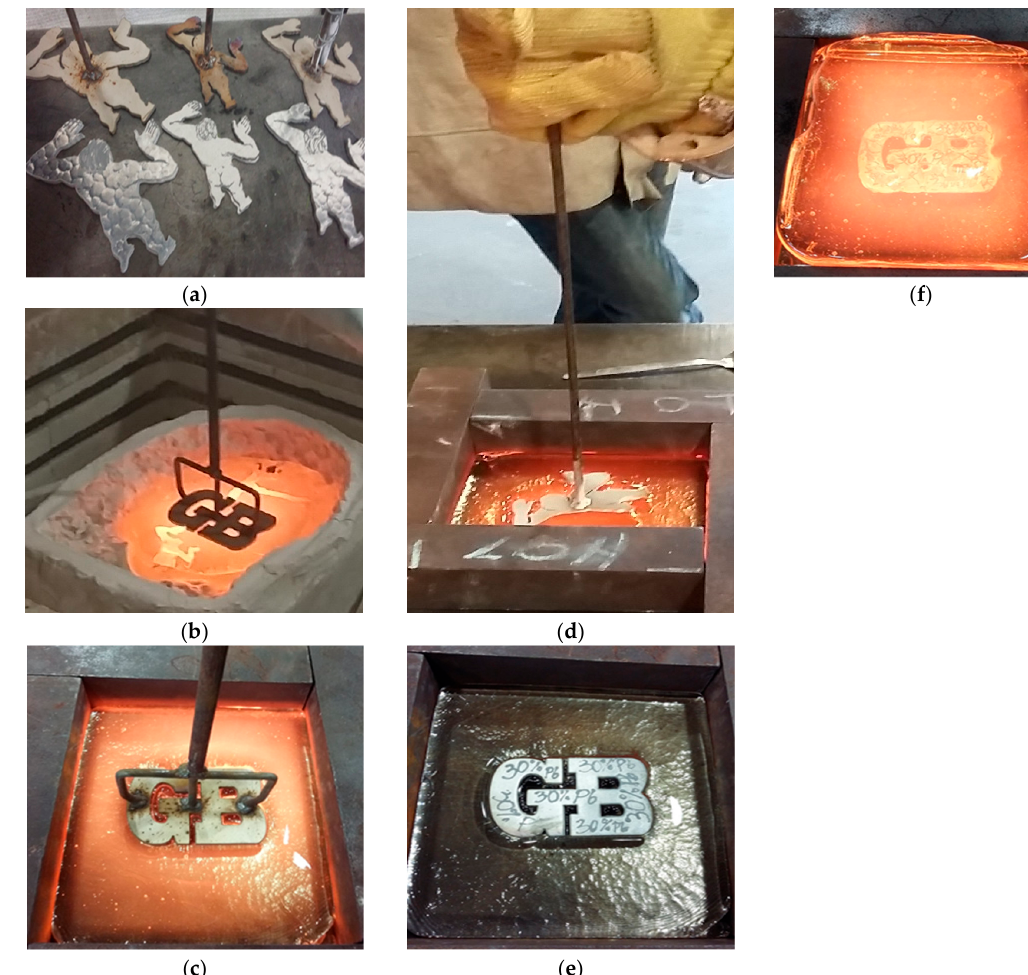
Figure 13. Stamps to make indentations in hot glass and application of lead and tin alloy inclusions: ( a ) Three sizes of nickel alloy stamps and lead and tin alloy inclusions exactly in the shape of the stamps; ( b , c ) indentation made by a stamp in the GB shape; ( d ) indentation made by a stamp in a man silhouette shape; ( e ) application of lead and tin alloy inclusion; ( f ) lead and tin alloy inclusion covered by second layer of hot glass; created by author.